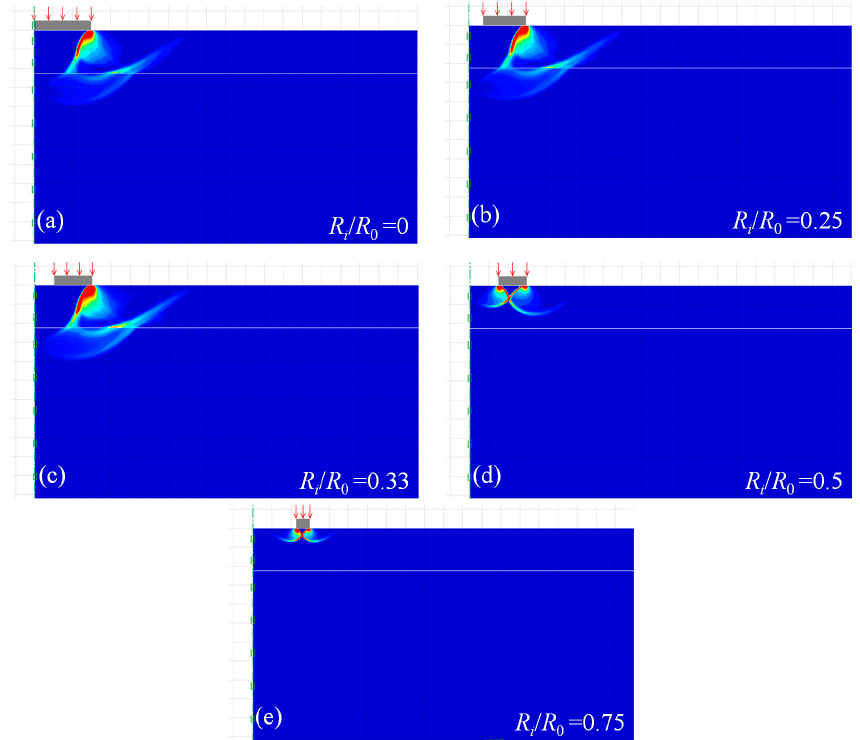
Figure 10. Upper bound collapse mechanisms for φ =35°, c u /( γ R 0 )=2, H / R 0 =0.75 with (a) R i / R 0 =0, (b) R i / R 0 =0.25, (c) R i / R 0 =0.33, (d) R i / R 0 =0.5, and (e) R i / R 0 =0.75.